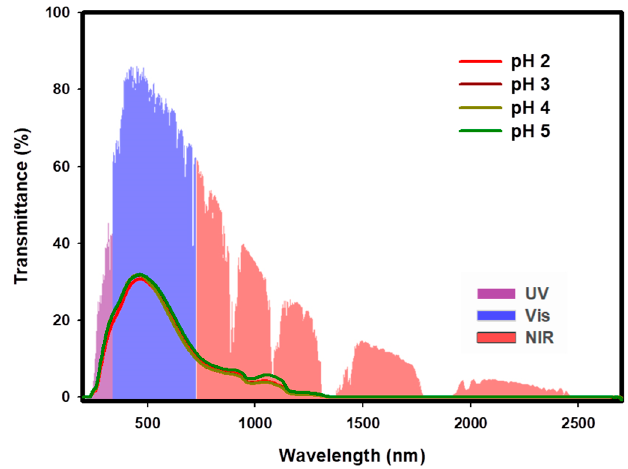
Figure 5. Transmittance spectra of PEDOT:P(SS-co-St) solutions of different pH. The standard solar irradiation spectrum is provided for comparison.